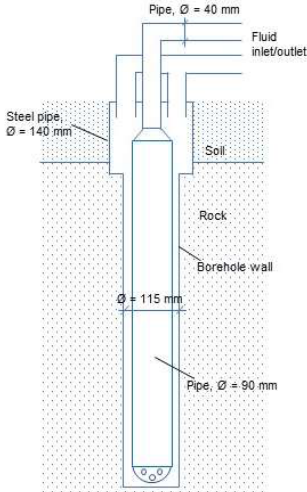
Figure 2. Layout of the borehole thermal energy storage (BTES) at Xylem, Emmaboda. The BTES consists of 140 boreholes, divided into seven sections, A–G, of 20 boreholes each. GT1–4 are temperature sensors inserted into the ground for storage operation and monitoring.